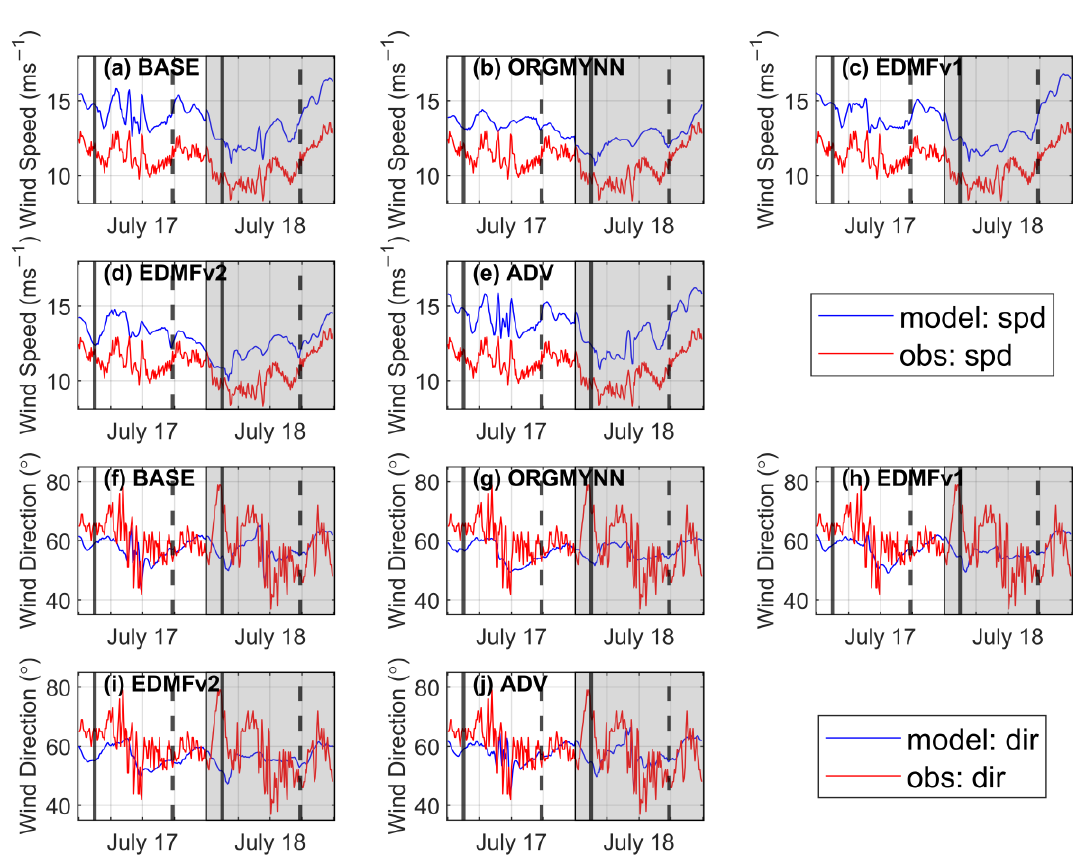
Figure 4. Comparisons of simulated and observed wind speed ( a – e ) at 81 m and wind direction ( f – j ) at 78 m. The blue line represents a model simulation, while the red line represents an observation. The grey shaded area represents the simulation results of 18 July for wind speed. Solid vertical lines represent the sunrise of each day, while dashed vertical lines represent the sunset of each day.